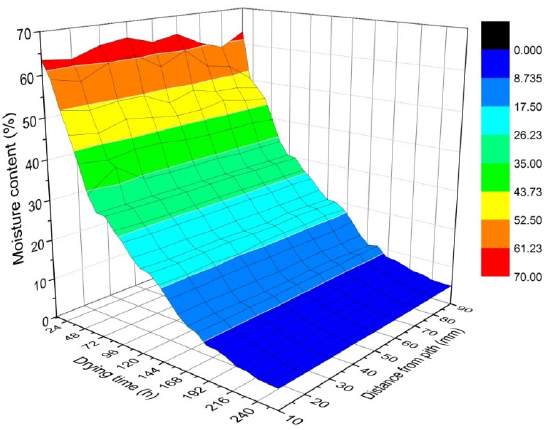
Figure 2. Illustration of the change in moisture content over time in wood disks.